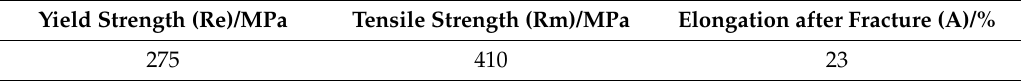
Table 3. Mechanical properties of S275 Steel.